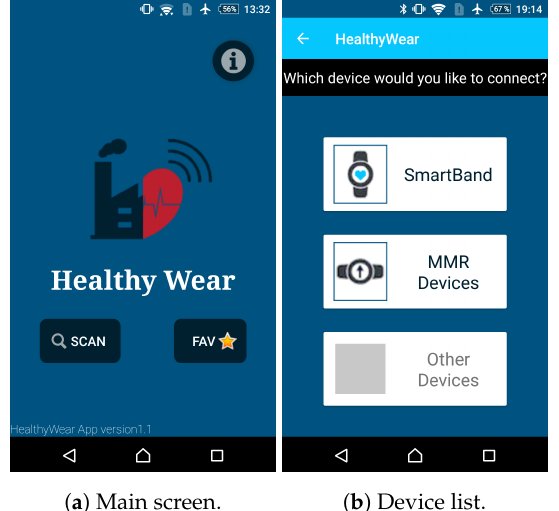
Figure 4. The app developed for data